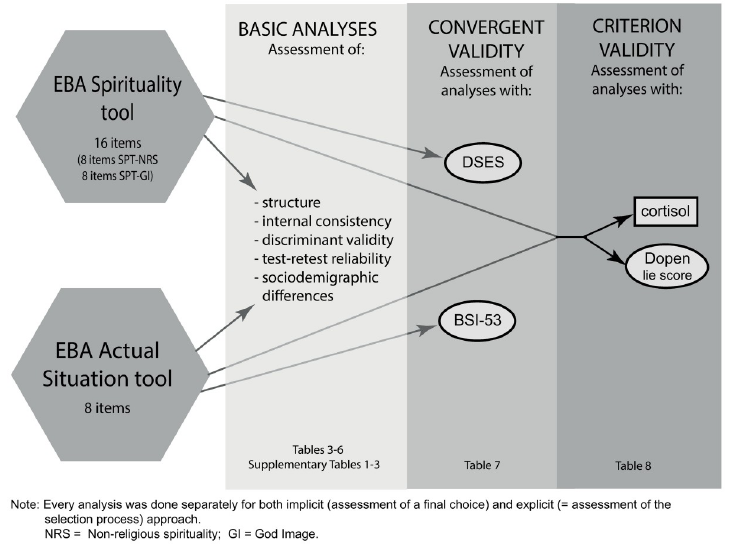
Fig 2. Description of the EBA tools and statistical analyses.